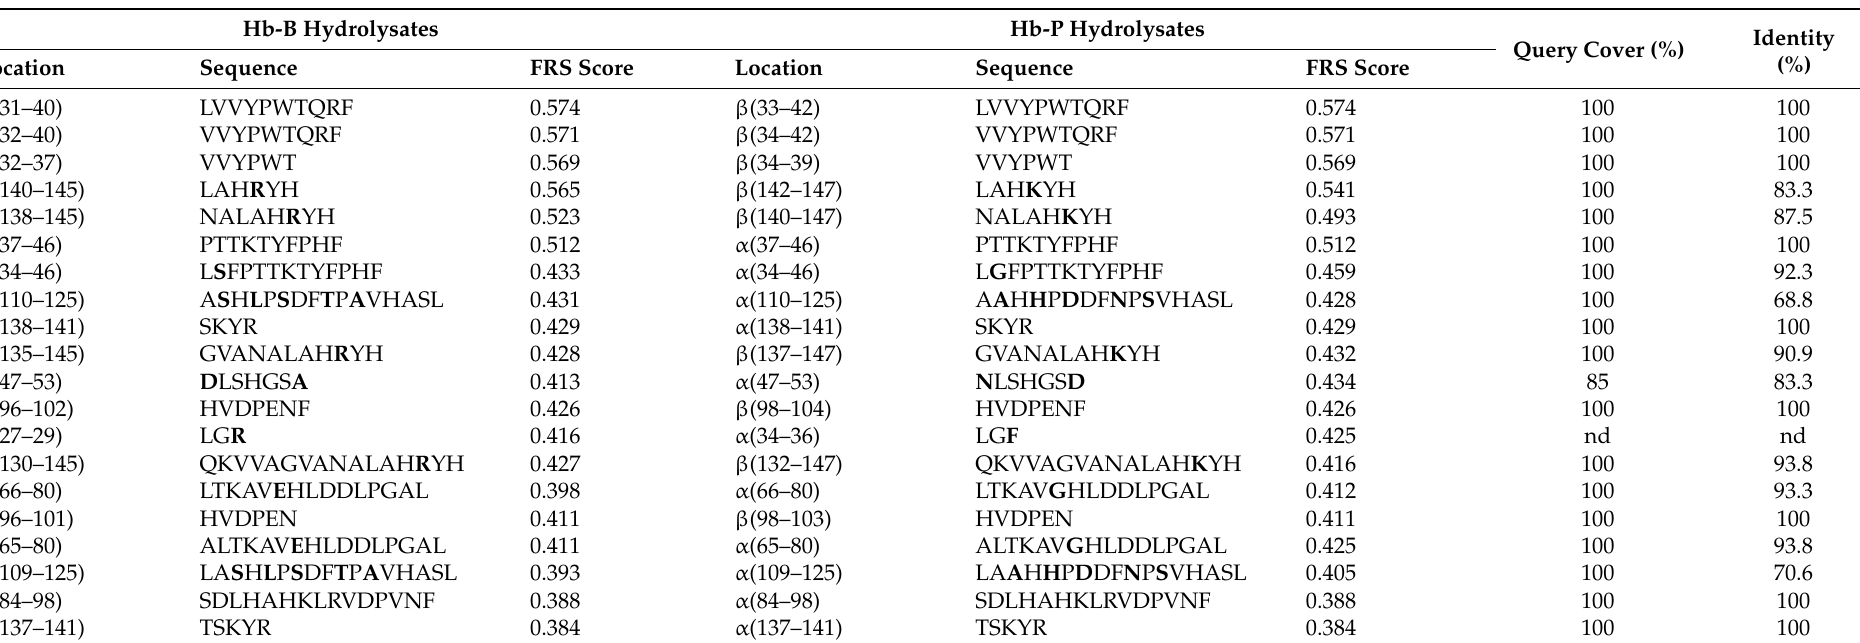
Table 3. Comparison of antioxidant activity prediction of common potential antioxidant peptides identified in hydrolysates of Hb-B and Hb-P by AnOxPePred algorithm and Basic Local Alignment Search Tool